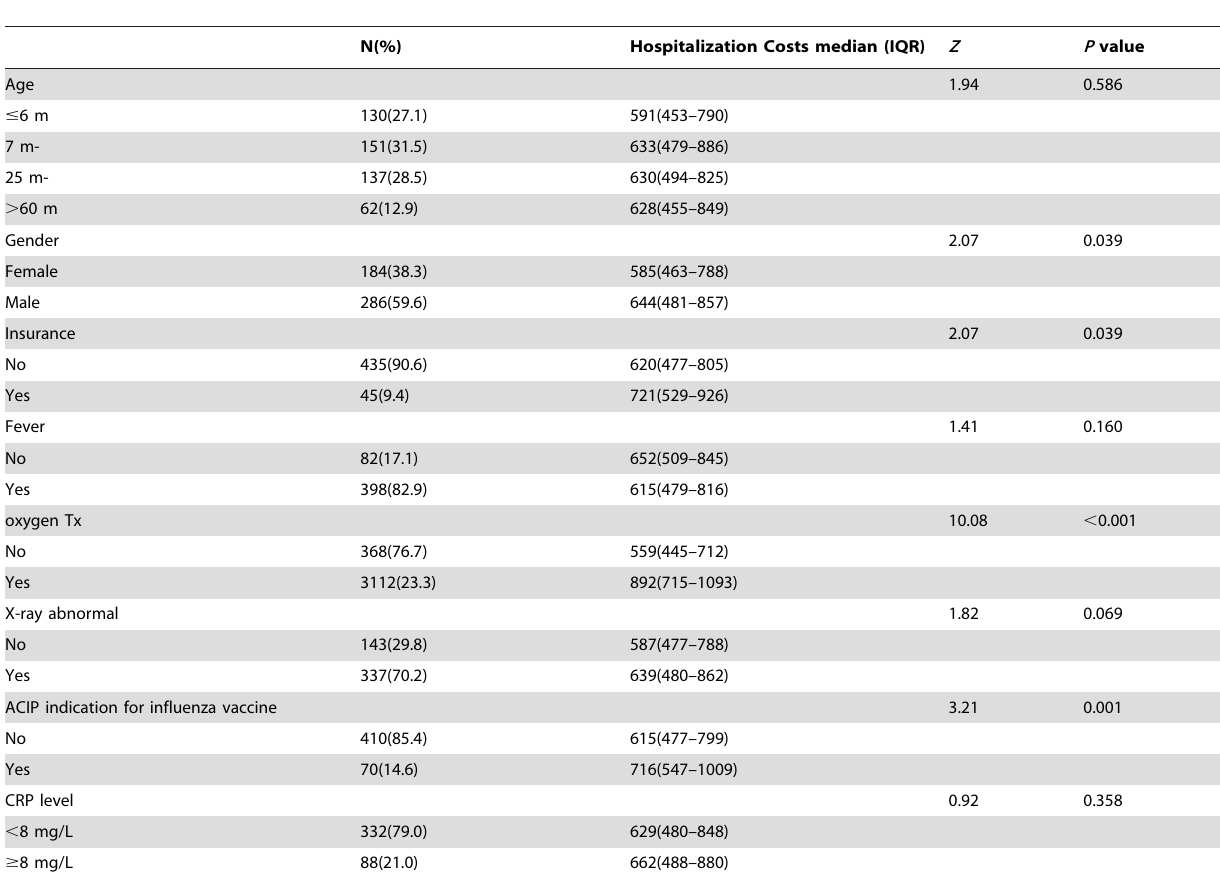
Table 5. Cost of hospitalization for the influenza infection children in Suzhou,